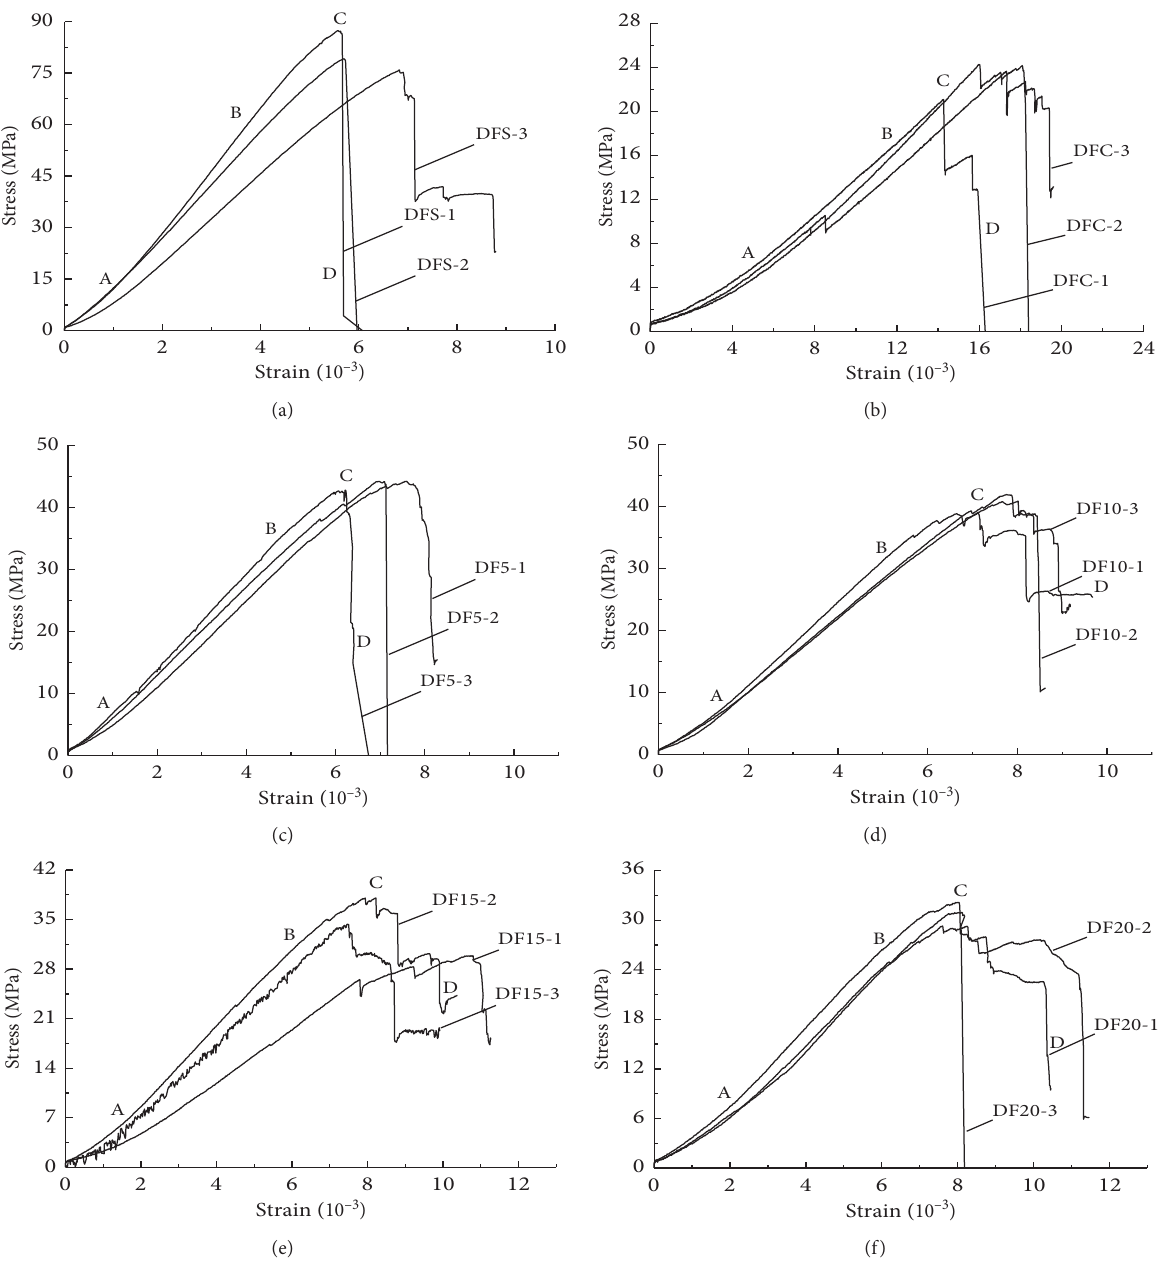
Figure 4: Stress-strain curves of (a) siltstone, (b) coal, or jointed siltstone with a coal layer of (c) 5 mm, (d) 10mm, (e) 15mm, and (f) 20mm thickness under uniaxial